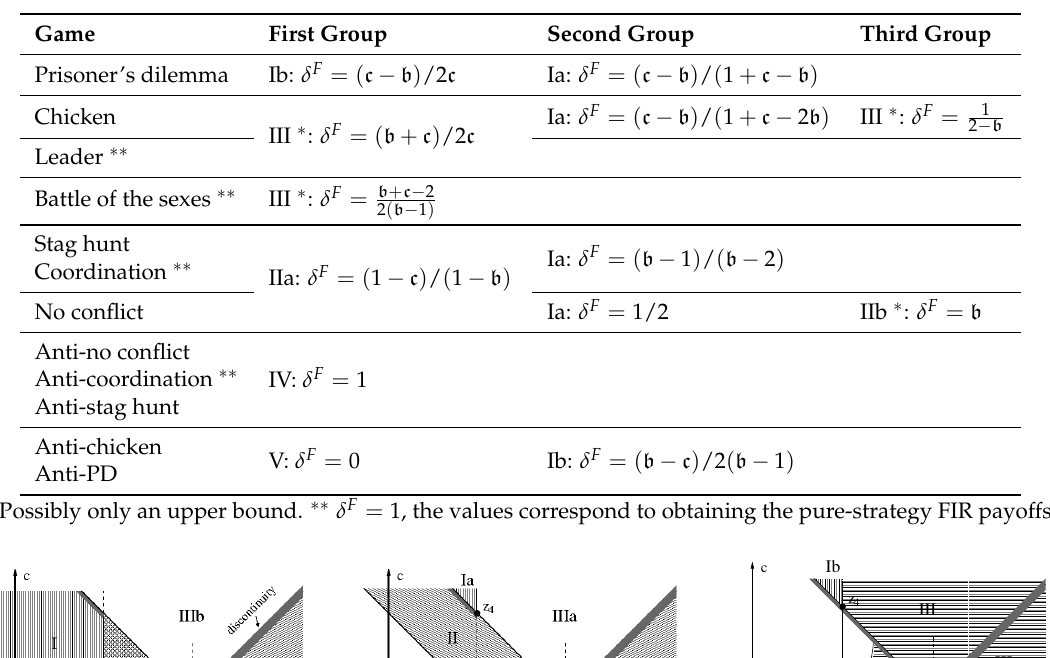
Table 3. The values of discount factor δ F in mixed strategies.